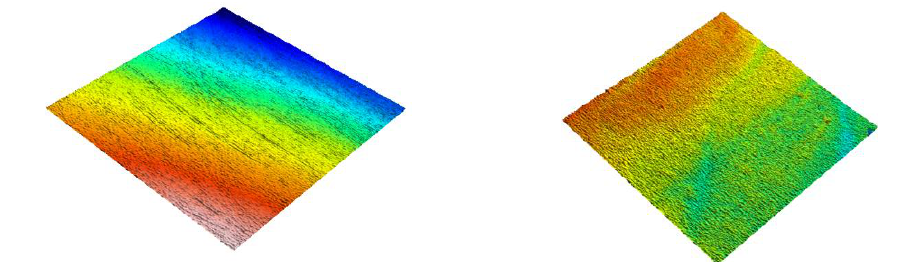
Figure 3. 3D image of Admira Fusion showing the surface of the resin-composite at baseline ( left image ) and after 20,000 cycles of toothbrushing abrasion ( right image ). Note the surface irregularities at baseline